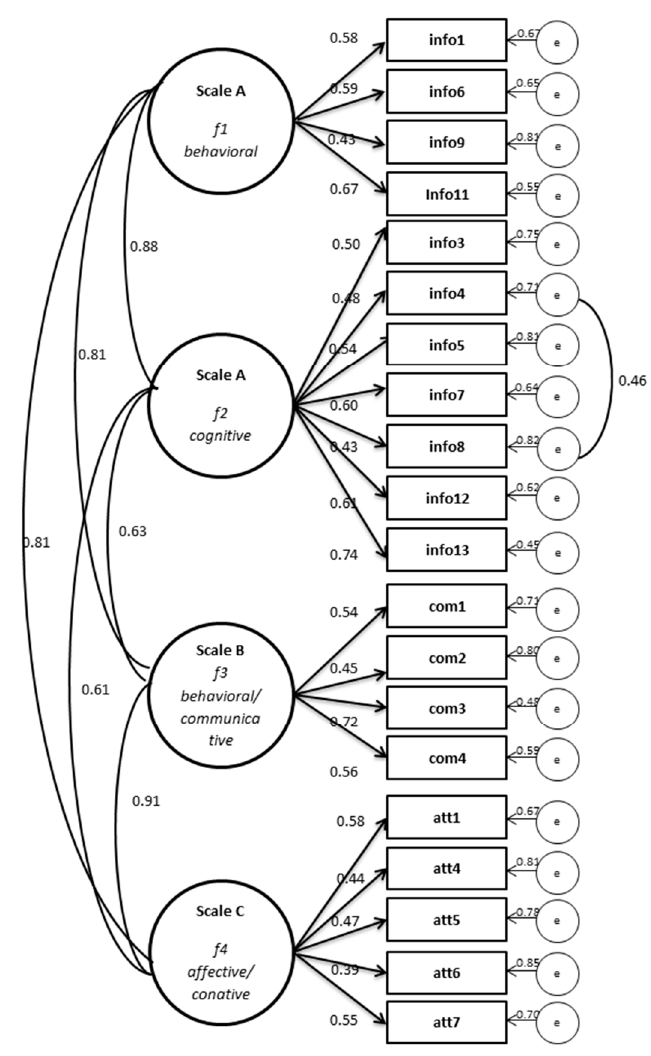
Figure 2. Standardized results of the CFA for the four-factor solution of the model underlying the MOHLAA-Q. Legend: Completely standardized estimates: Factor correlations, factor loadings, residual variance.